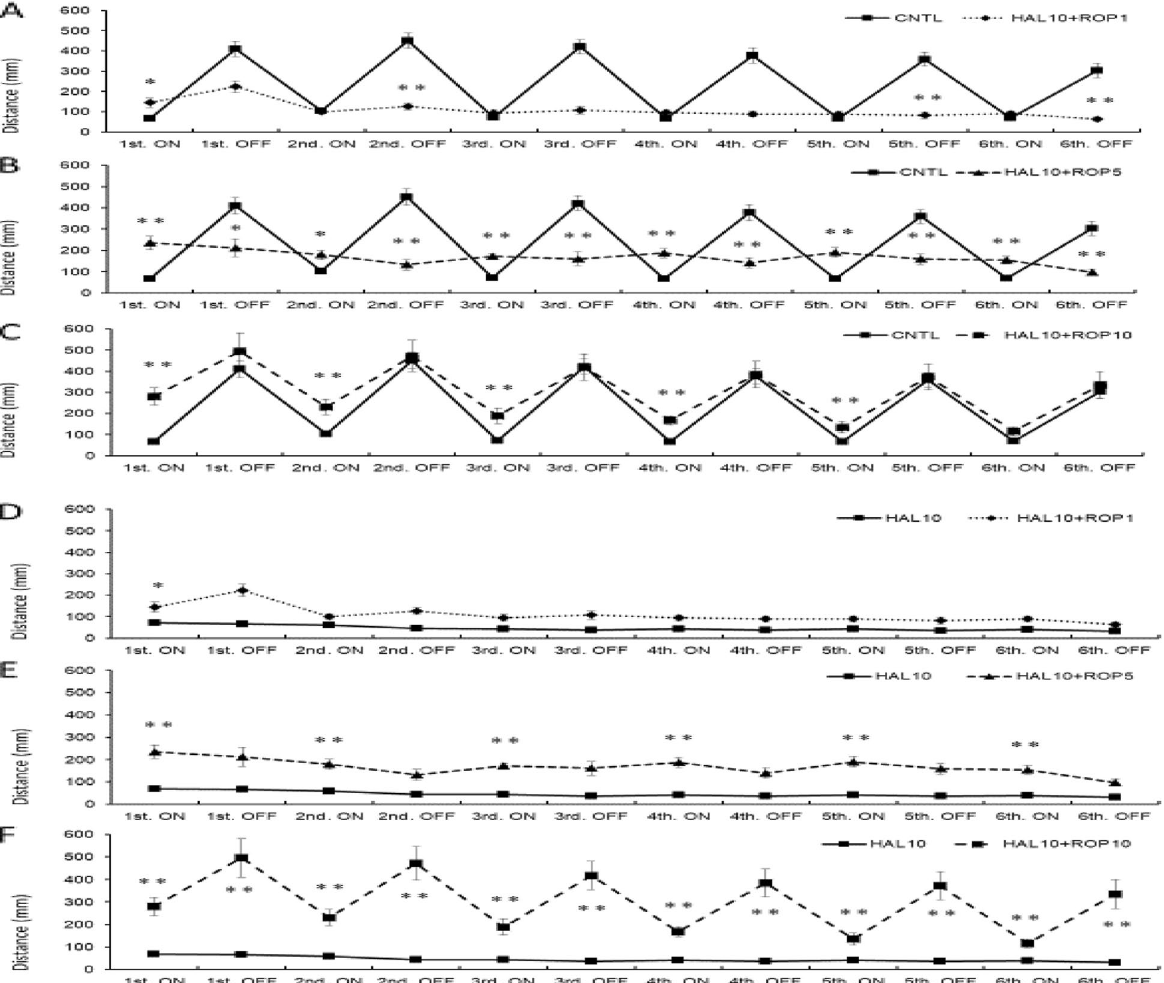
Fig. 5. The effect of CBD and ROP on activity of zebrafish normal model. Addition of 1, 5, 10 mg/L of CBD and ROP to the normal model clearly were different from HAL 10 mg/L. Especially, the travel distances at both CBD 10 mg/L and ROP 10 mg/L were clearly different from the CNTL. CNTL: Control, DMSO: dimethyl sulfoxide 0.05%, HAL10: Haloperidol 10 mg/L, CBD 1, 5, 10: Cannabidiol 1, 5, 10 mg/L, ROP 1, 5, 10: Ropinirole 1, 5, 10 mg/L. Tukey–Kramer test; CNTL vs ** p <0.01, HAL10 vs # p <0.05, HAL10 vs ## p <0.01, ns; not significant. All values are presented as means